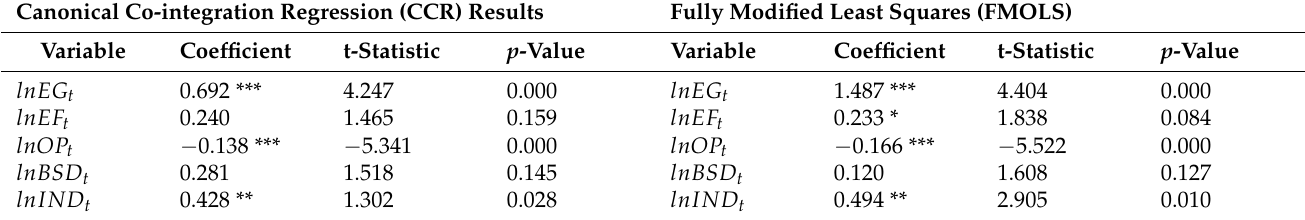
Table 5. FMOLS and CCR results.